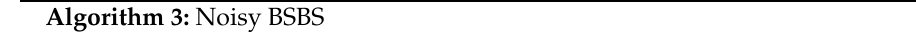
Algorithm 3: Noisy